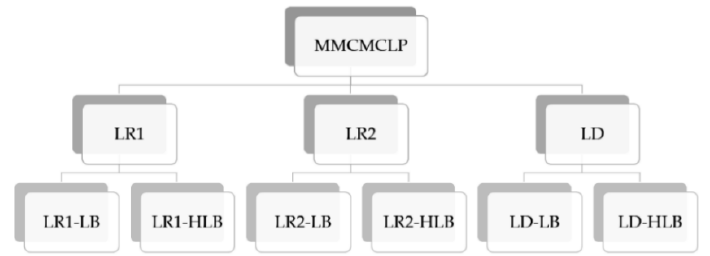
Figure 5. Structure of the solving procedures used to obtain bounds.